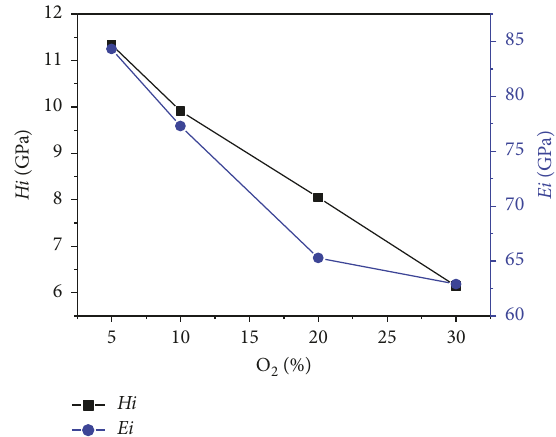
Figure 3: Hardness and Young’s modulus of TiO 2 versus flux rate of